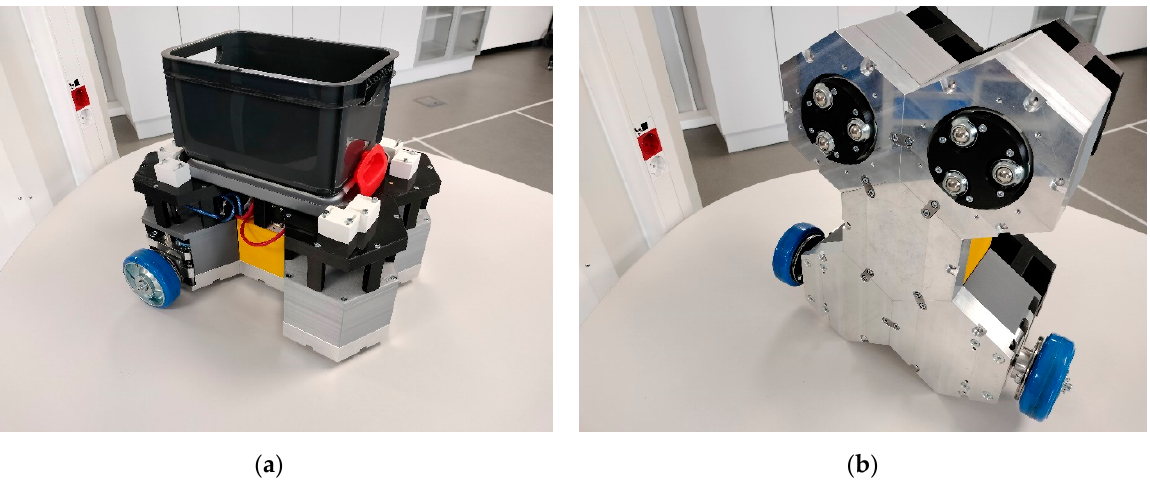
Figure 3. Modular mobile robot with two conventional wheels (3D model). ( a ) Isometric view. ( b ) Top view.